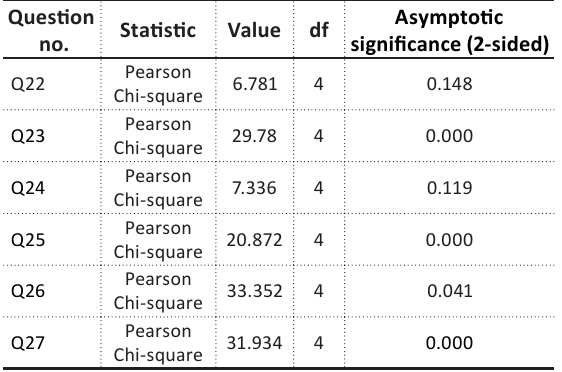
Table 5. Millennials prefer to buy brands that actively invest in manifesting activism